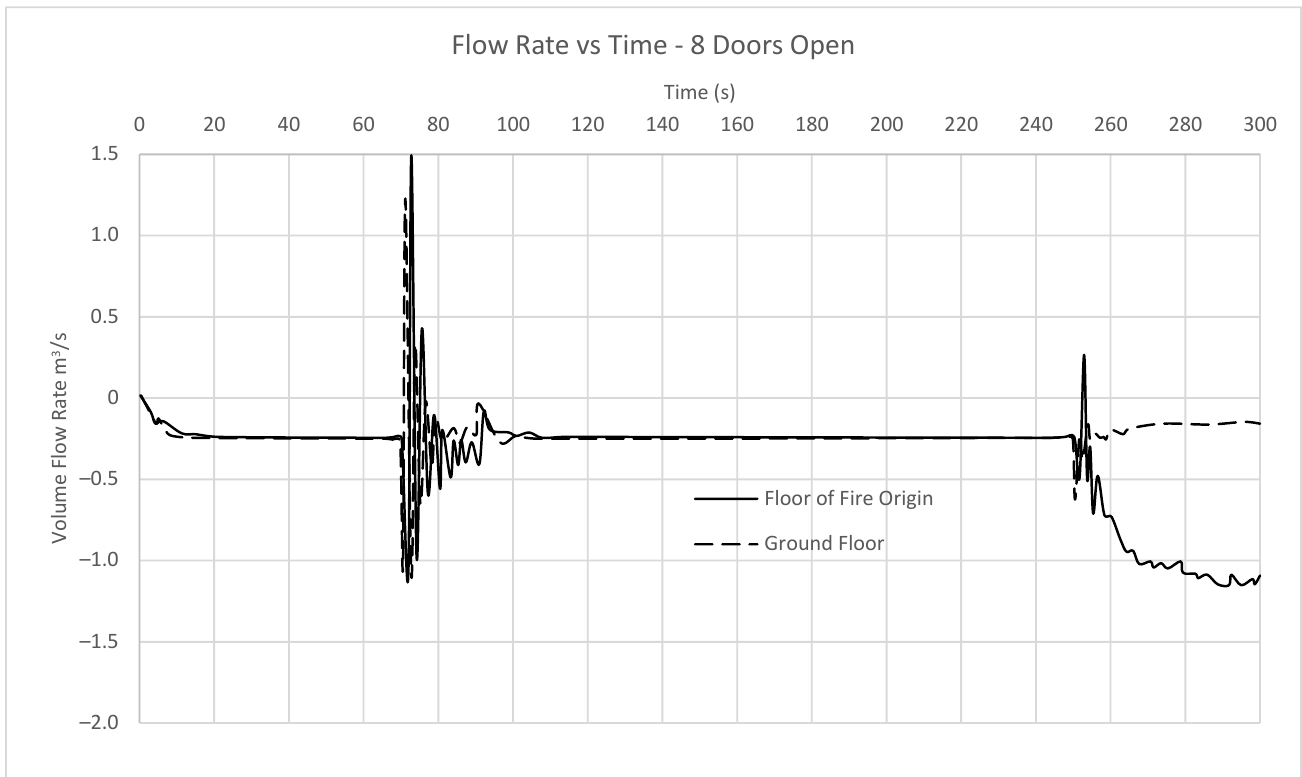
Figure 11. Volume flow rates through the ground floor door and floor of fire origin with eight doors open into the shaft.